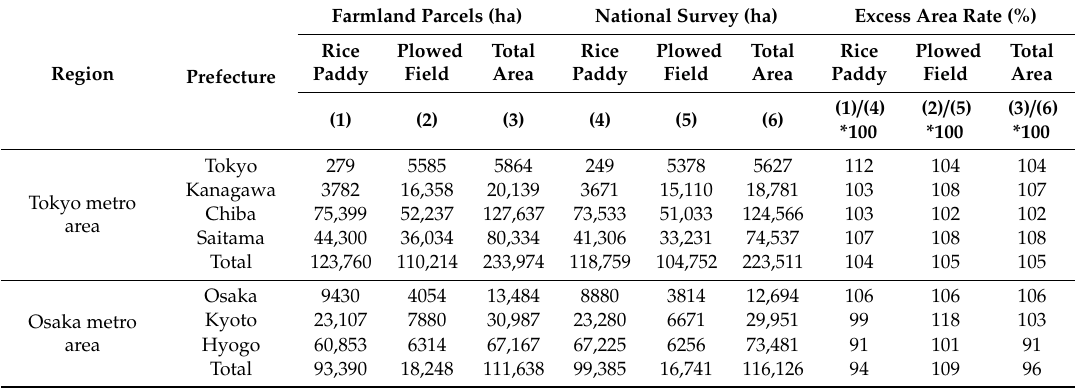
Table 2. Comparisons of total agricultural land areas between databases.